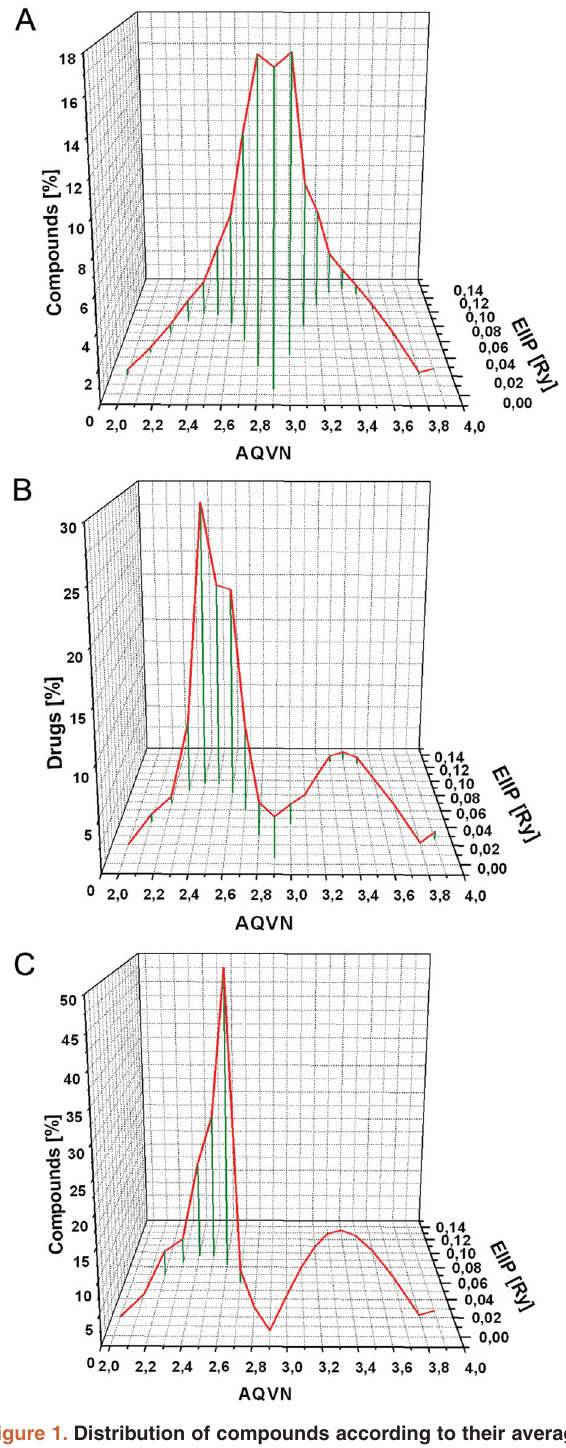
Figure 1. Distribution of compounds according to their average quasivalence number (AQVN) and electron-ion interaction potential (EIIP) values. ( A ) 45010644 compounds from the PubChem database (http://www.ncbi.nlm.nih.gov/pccompound); ( B ) FDA-approved drugs which are active against Ebola virus infection (Dataset 1) 2,3 ; ( C ) Entry inhibitors of Ebola virus (Table